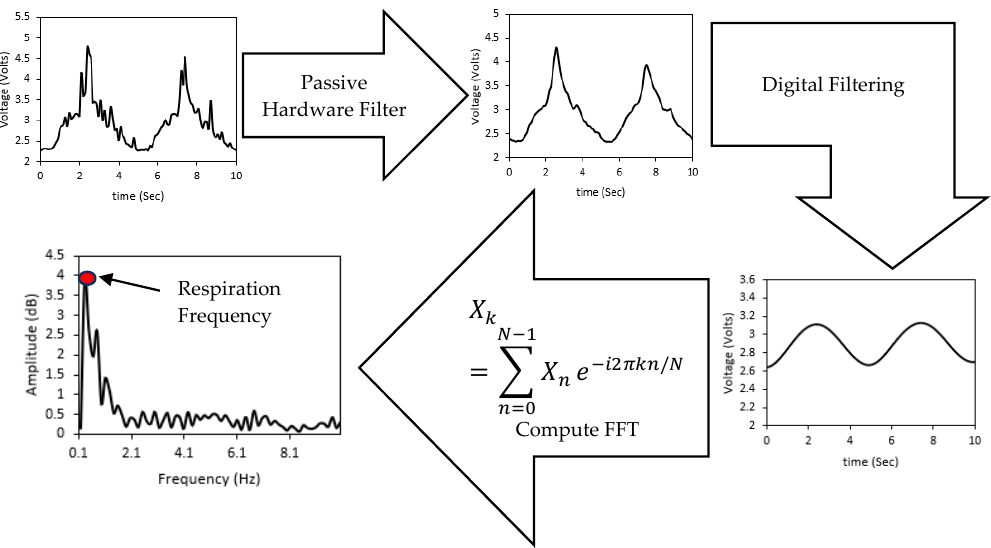
Figure 6. The flow chart of the output signal from the developed